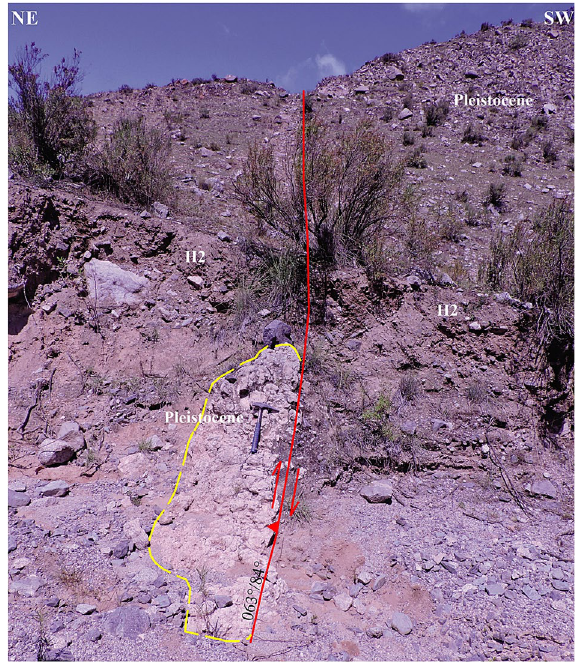
Fig. 13 View of folds in the foothills, the folded strata correspond to the Lomitas Pegadas Formation. a Anticline NW strike. b NE direction fold whose strata show strong dip